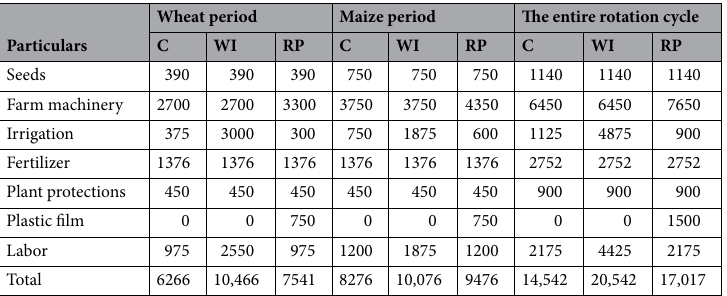
Table 1. Effect of different planting strategies on annual average cost (Yuan ha –1 ) of cultivation of wheat– maize cropping system. C, conventional rain–fed flat planting; WI, well-irrigation planting; RP, ridge-furrow planting with plastic film mulch over the